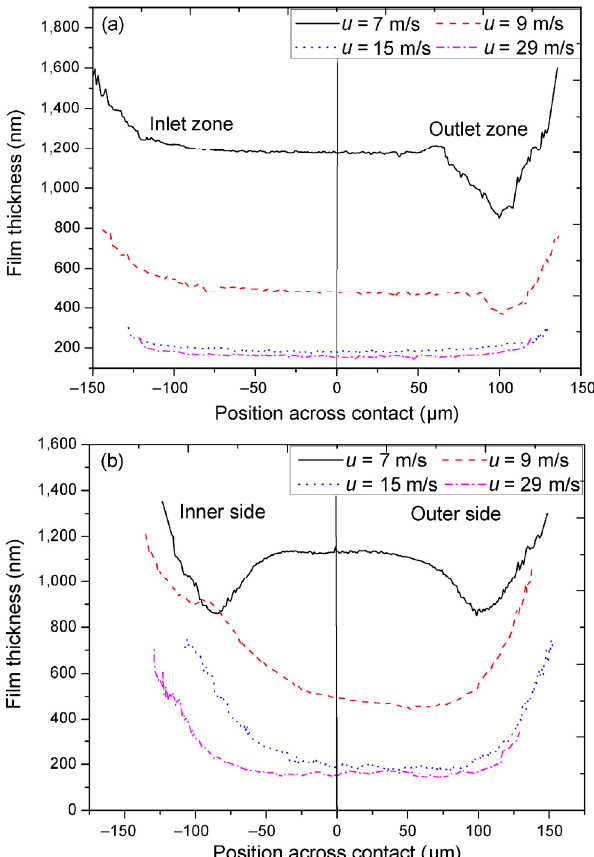
Fig. 3 Mid-plane film thickness profiles (a) parallel to and (b) perpendicular to the direction of entrainment speed under starved lubrication. The perpendicular axis is along the direction of centrifugal forces. Pure rolling, p H = 431 MPa, t 0 = 25 ° C, oil supply: 51 mL/min,